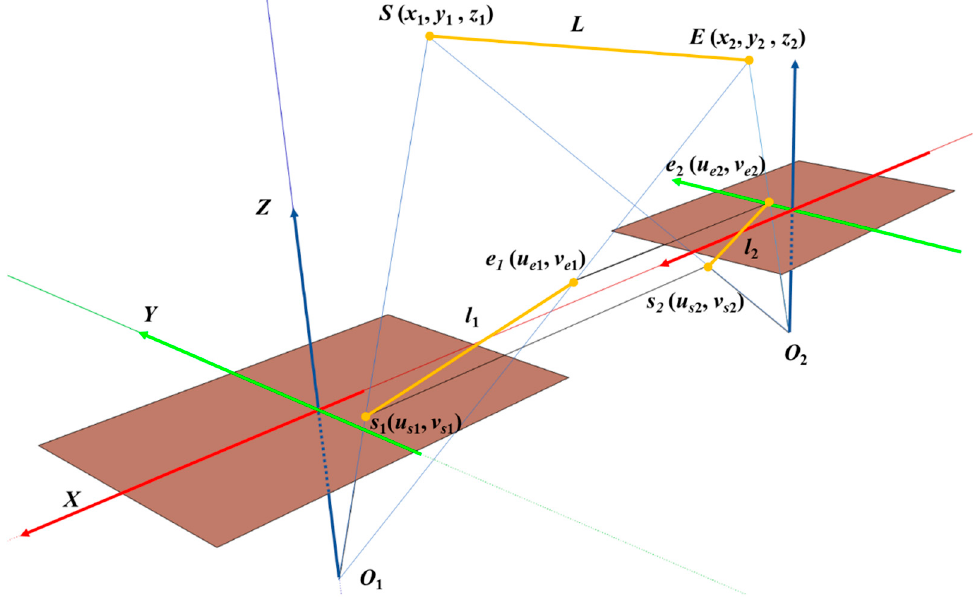
Figure 2. Space line projection and geometric constraint relationship.